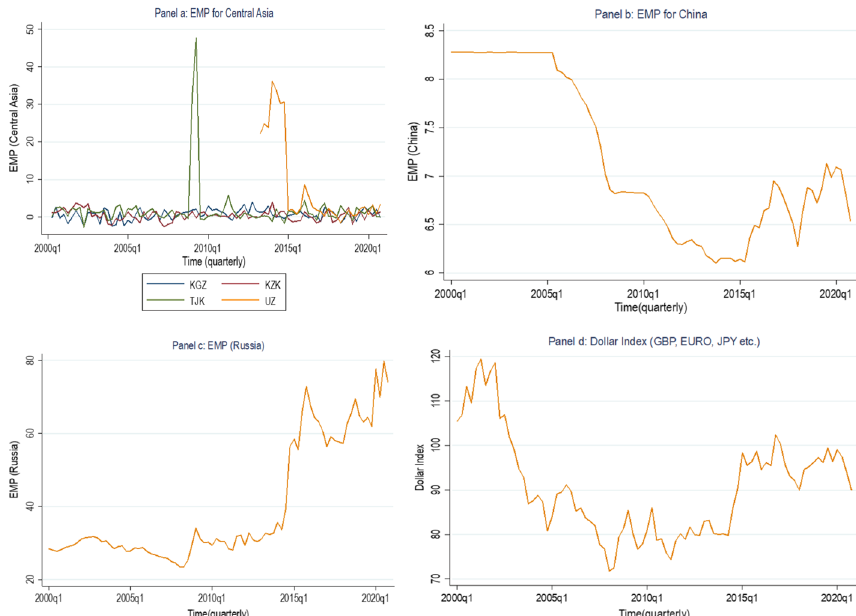
Fig. 3 Exchange market pressures for CAE, China and